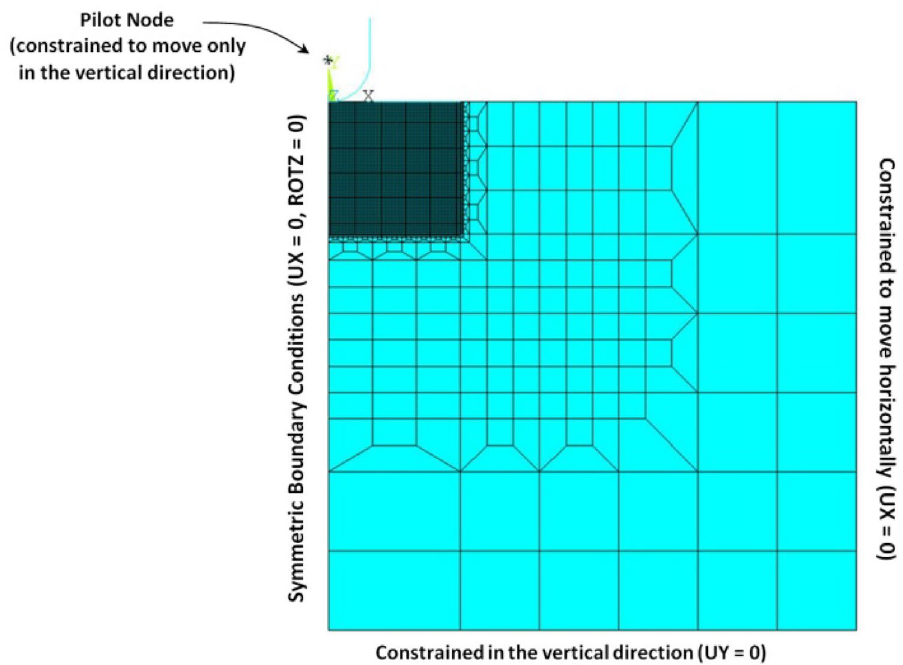
Fig. 4. 2D axisymmetric model